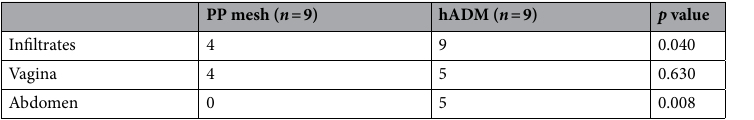
Table 2. Number of inflammatory infiltrates observed. Statistical analysis was performed using chi-square test. n = number of analyzed samples.